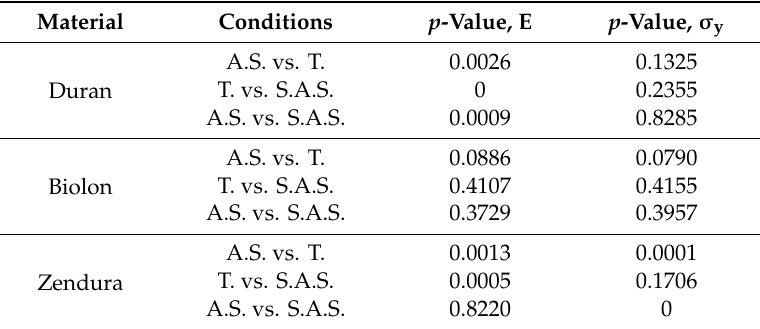
Table 5. Results of t-test for all the materials and conditions